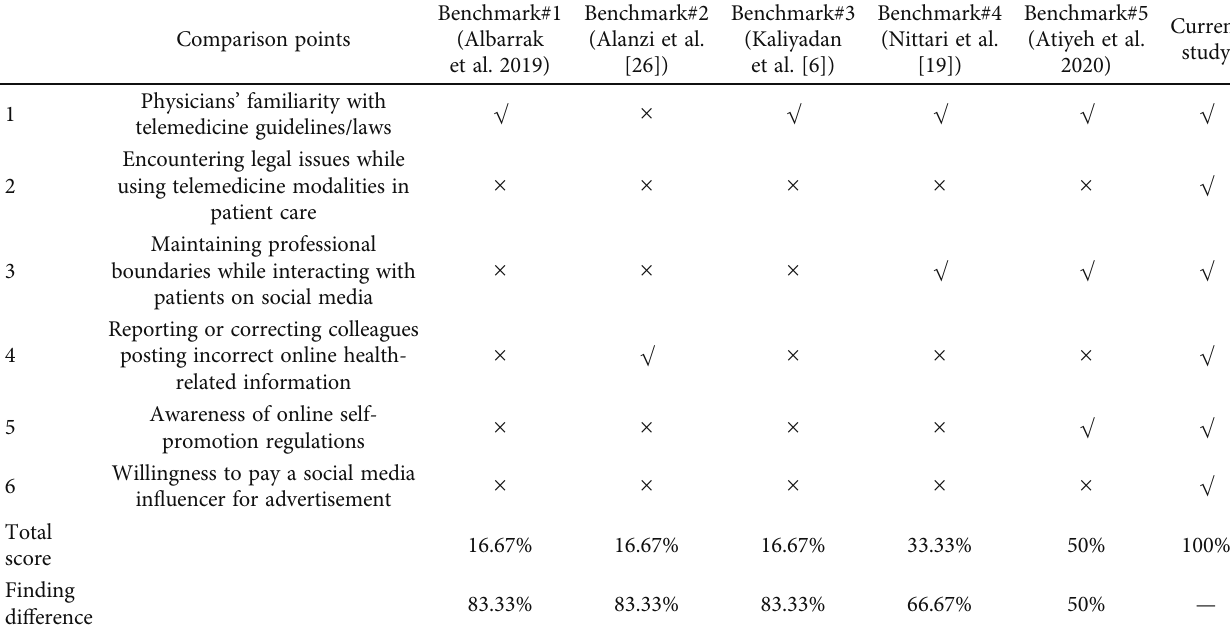
Table 2: Comparison points between benchmark articles and the current